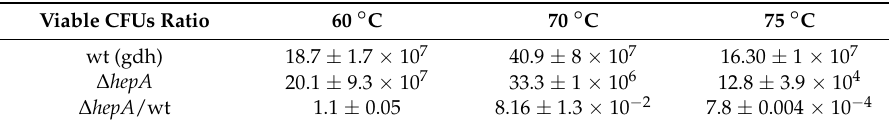
Table 4. Sensitivity to temperature of hepA mutants.